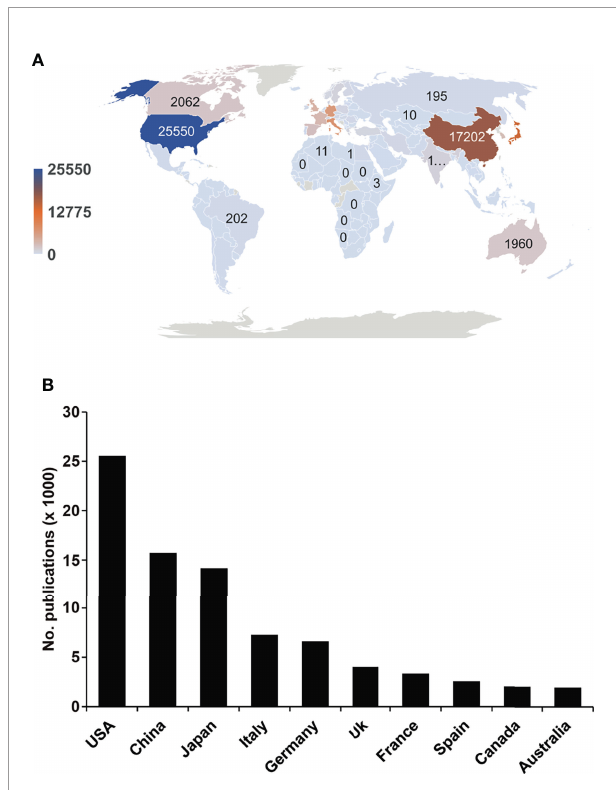
FIGURE 2 | Global pancreatic cancer research differs signi fi cantly between regions. (A) The global distribution of pancreatic cancer publications in the last 25 years by number is shown. We extracted country information based on the publication ’ s af fi liation. The darker the color is, the greater the volume of publications. Signi fi cant head effect: The number of posts in the Northern Hemisphere is much higher than that in the Southern Hemisphere. (B) Top 10 countries with the highest publication numbers in pancreatic cancer